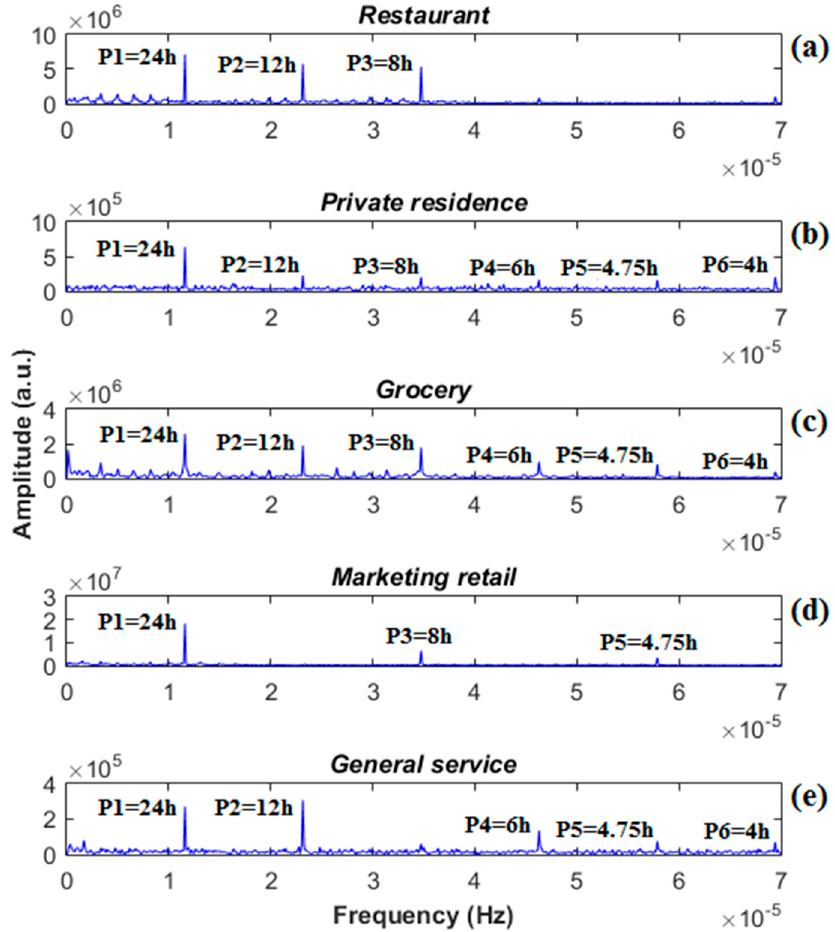
Figure 3. Fourier spectrum of the active power with the peaks highlighted: ( a ) restaurant; ( b ) private residence; ( c ) grocery; ( d ) marketing retail establishment; ( e ) general service.